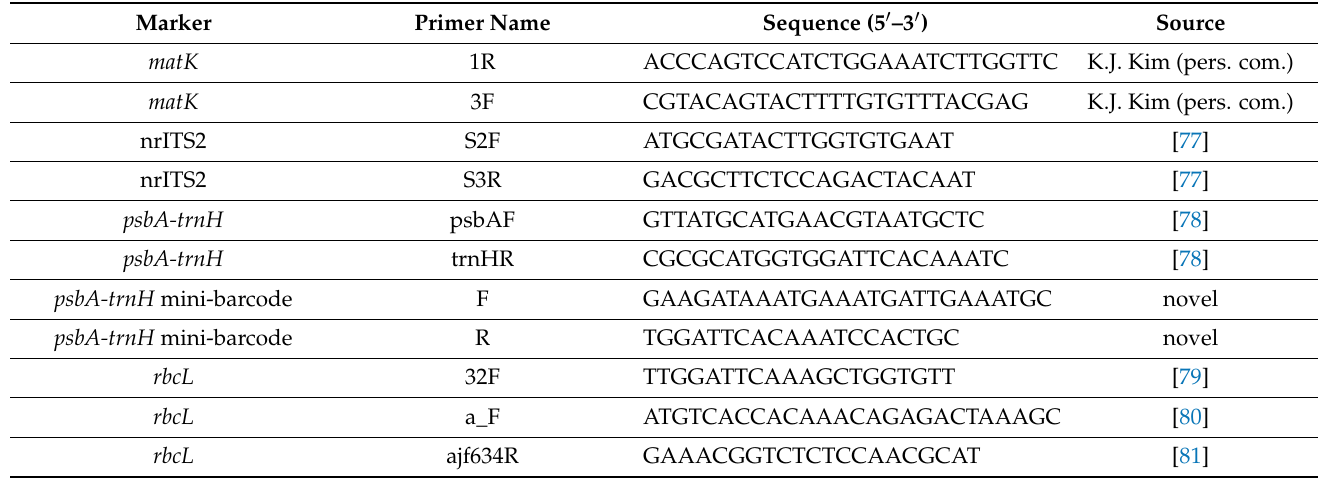
Table 3. PCR primers used for amplification and sequencing.